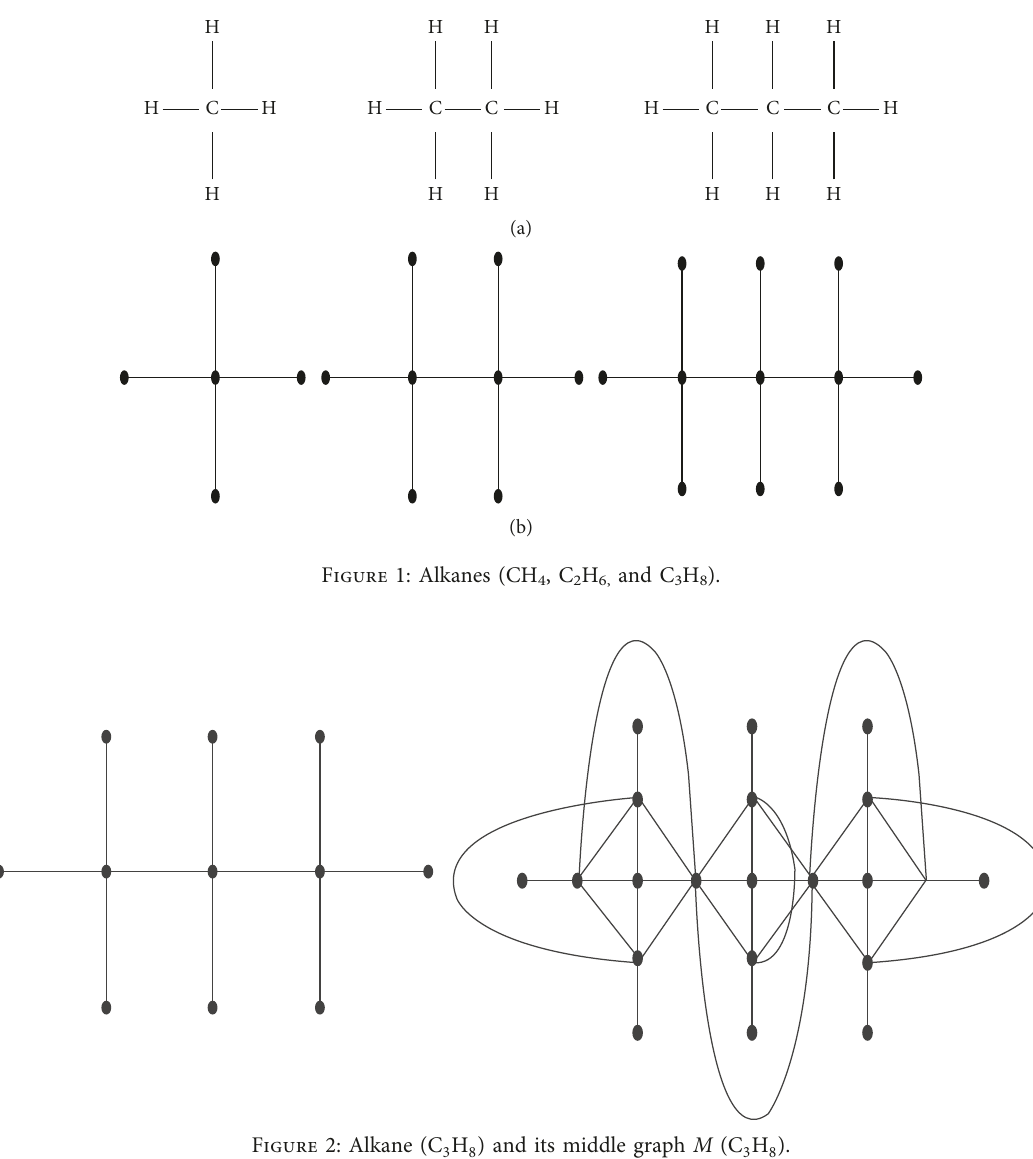
H ) and its middle graph M (C 3 8